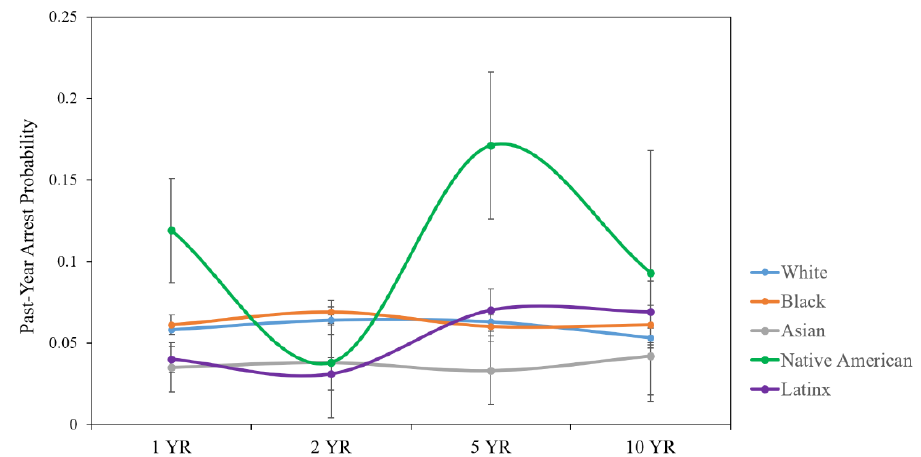
Figure 2. Racial/ethnic differences in past-year arrest probability trajectories over time with covariate-adjusted means and standard error bars.